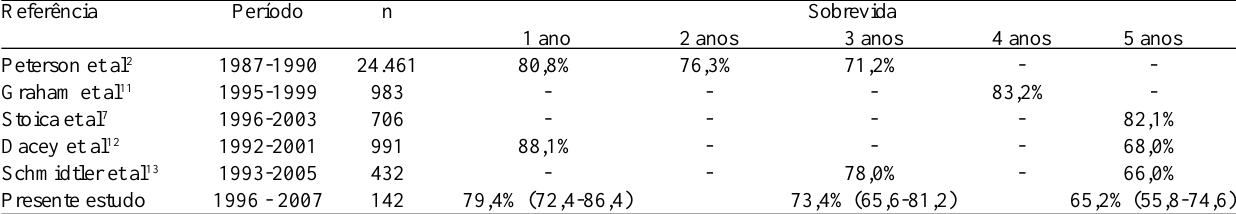
Tabela 2. Comparação dos dados da literatura sobre sobrevida de octogenários submetidos à CRM isolada com os observados no presente estudo (entre parênteses, intervalo de confiança de